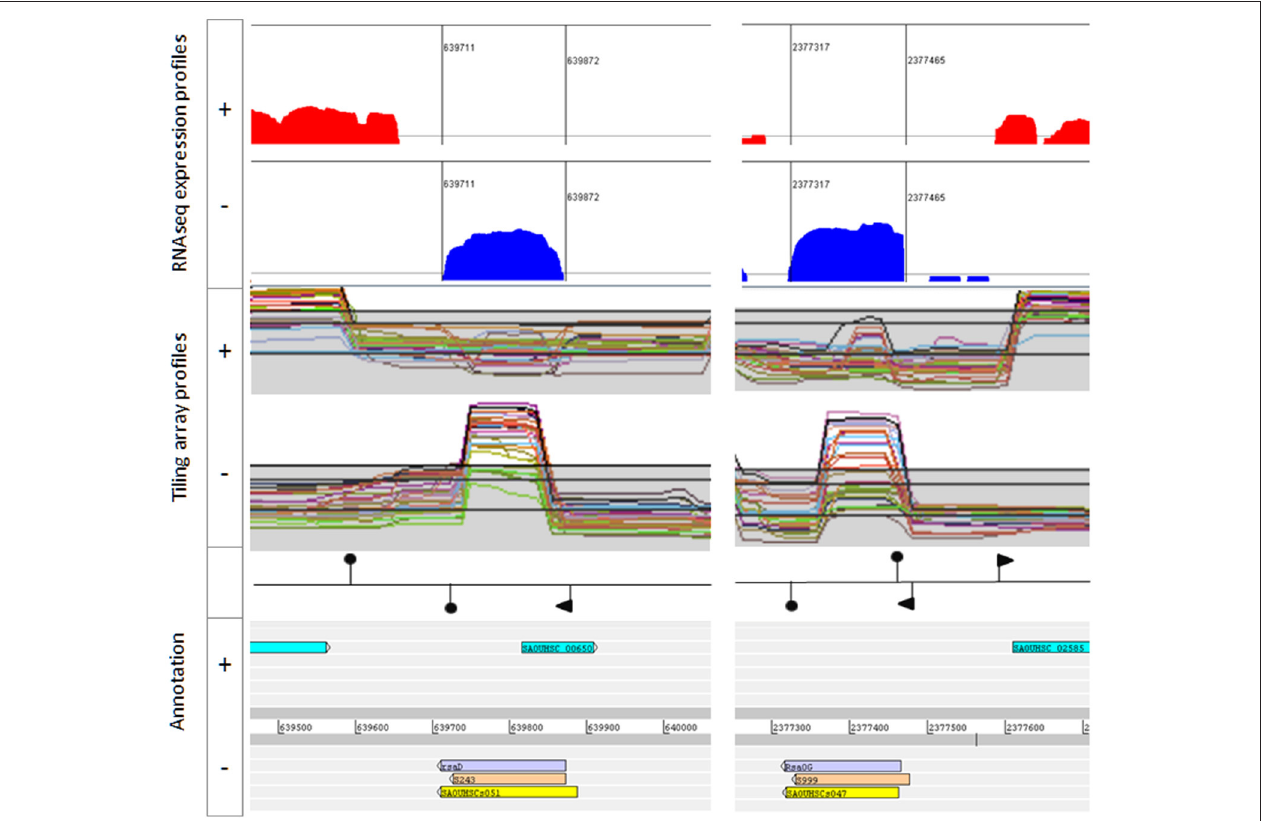
FIGURE 2 | Example of bona fide sRNAs. RsaD (Left) and RsaOG (Right) . Upper: Artemis viewer window showing read log-coverages from pooled RNA samples extracted from HG003 grown in 16 growth conditions. Middle panel: screen snapshots of tiling array data from HG001 grown in different conditions (http://genome. jouy.inra.fr/cgi-bin/aeb/index.py, Mäder et al., 2016). Lower: annotations including genomic coordinates and sRNA names from Carroll et al. (yellow), Mäder et al. (light orange), and this study (mauve). Promoters (flags) and transcription terminators (hairpin loops) are placed according to Mäder et al. and/or TranstermHP software terminator predictions ( Kingsford et al.,